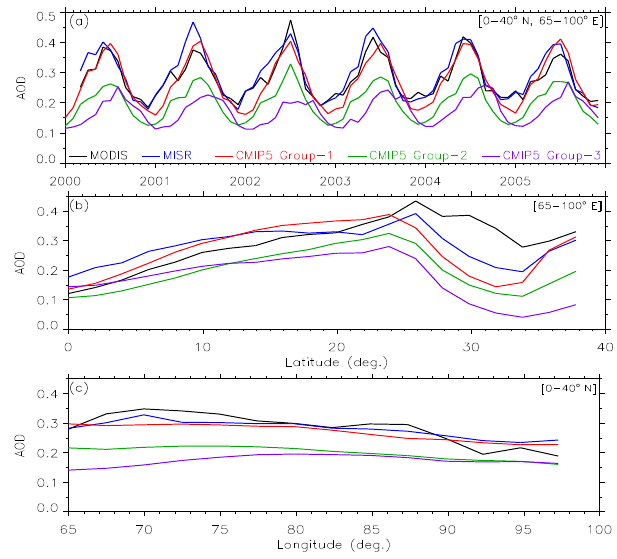
Figure 5. (a) Time series of AOD for 2000–2005 derived from MISR, MODIS, and the three model groups defined in the text. (b) Variation of AOD from different data sets with latitude. (c) Vari- ation of AOD from different data sets with